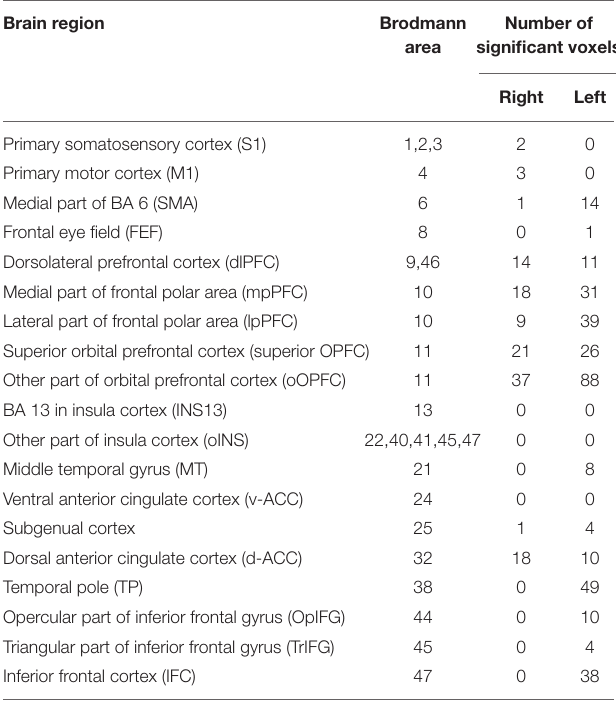
TABLE 3 | Number of voxels with significant differences in CSD of theta oscillations between the MTrP and non-MTrP groups in each brain